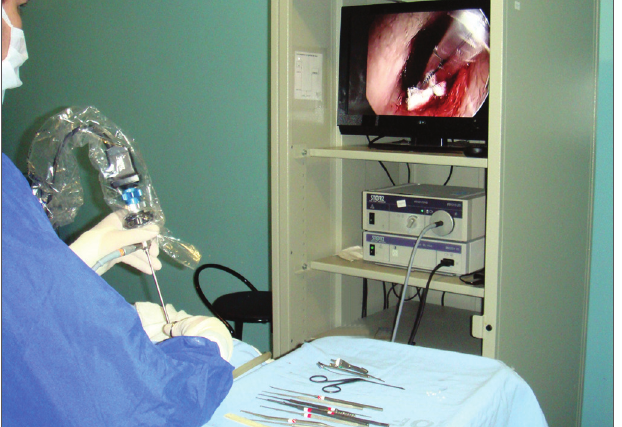
Figura 1. Posicionamento na sala de cirurgia. O otorrino realiza o procedimento olhando diretamente ao monitor presente à sua frente. Os instrumentos devem ser posicionados em local de fácil acesso, como nesta mesa ao lado do cirurgião.